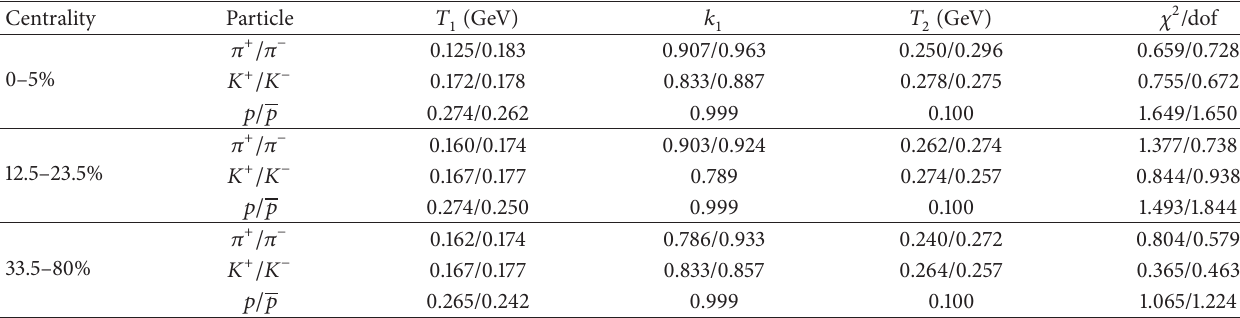
Table 2: Parameter values corresponding to the solid curves in Figure 1. The relative errors for the effective temperatures and ratios are about 5% and 3%, respectively. The values for positively/negatively charged particles are given in terms of “value values being different.